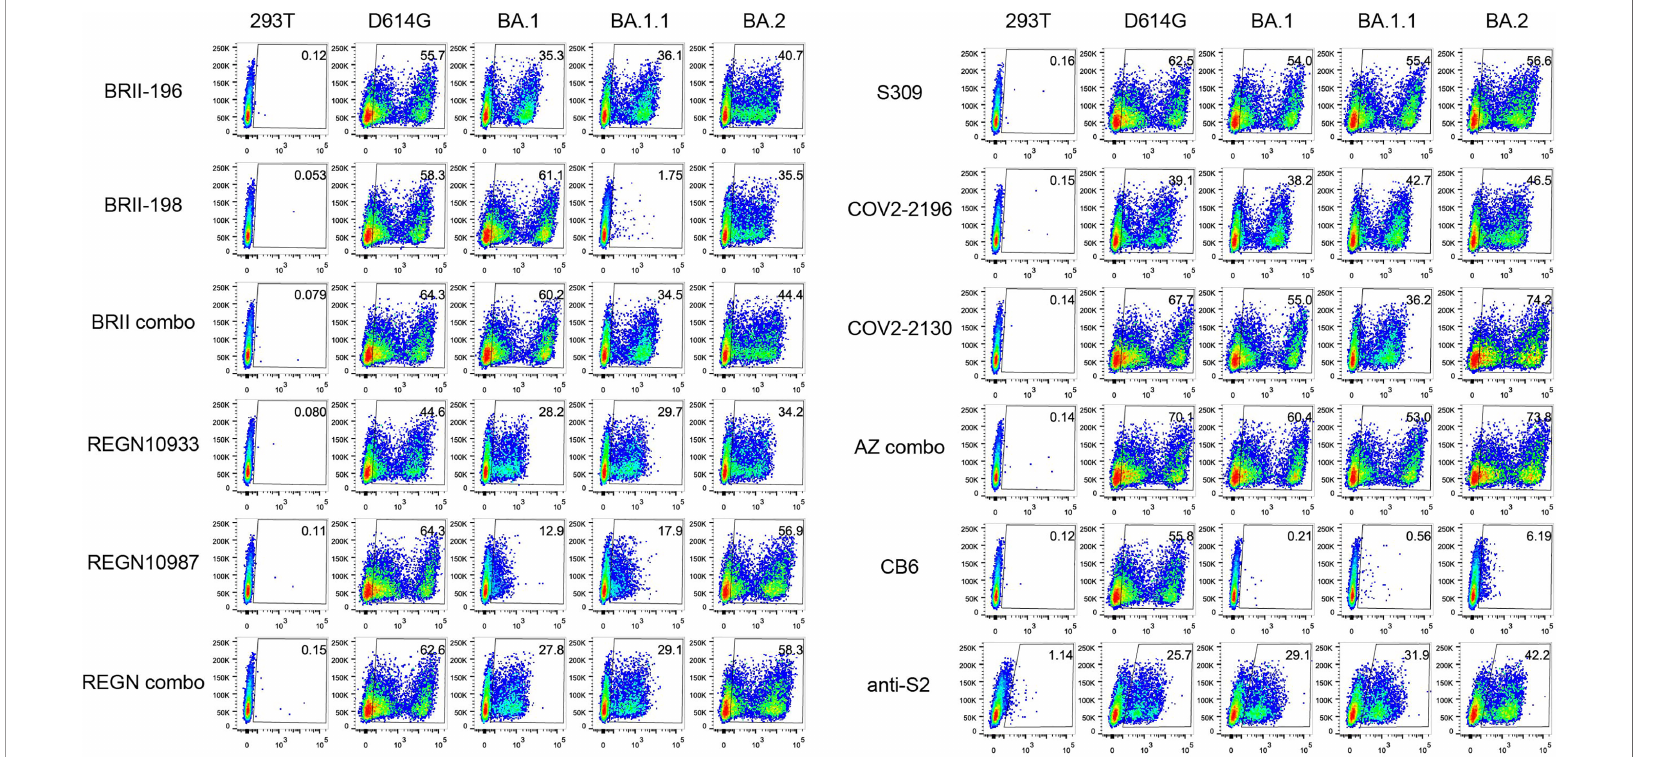
FIGURE 2 | Antibody binding to spikes of Omicron BA.1, BA.1.1, and BA.2 expressed on the cell surface. Binding of all tested mAbs, and their clinical-relevant combinations to the spike protein of WT D614G, Omicron BA.1, BA.1.1, and BA.2 expressed on the surface of HEK293T, measured by fl ow cytometry. Anti-S2 is a S2-speci fi c antibody used for positive control. The numbers highlighted in the gates represent the percent of positive cells detected by indicated antibodies or combinations. The result shown was representative of two independent